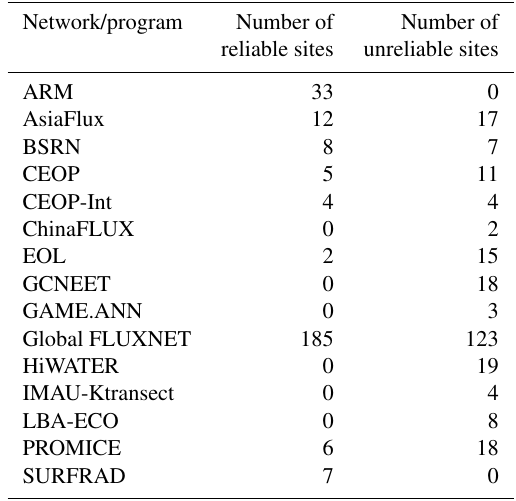
Table 5. Summary of the selected reliable and unreliable sites based on ETC for each observation